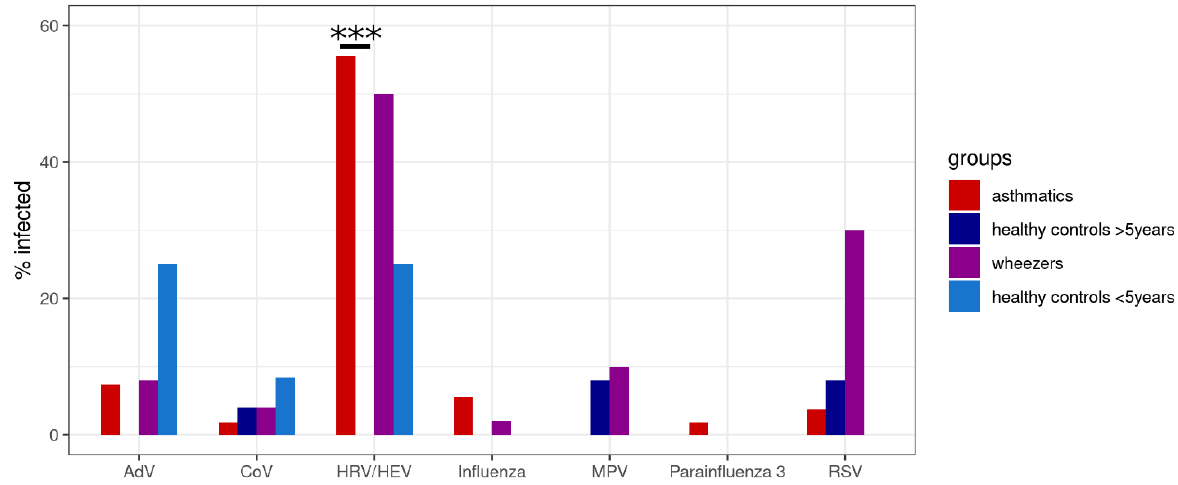
Figure 1. Frequency of infection in different groups. The frequency of infection with each of the studied viruses was compared between asthmatics or wheezers and age-matched controls. Rhinovirus infection levels are significantly higher in asthmatics than in older healthy controls. There is also a substantial difference in RSV infection levels between wheezers and younger controls. The pairwise comparisons were conducted with Fisher’s exact test, then the p -values were corrected using the FDR method. *** p < 0.001. Abbreviations: AdV = adenovirus, CoV = coronavirus, HRV/HEV =